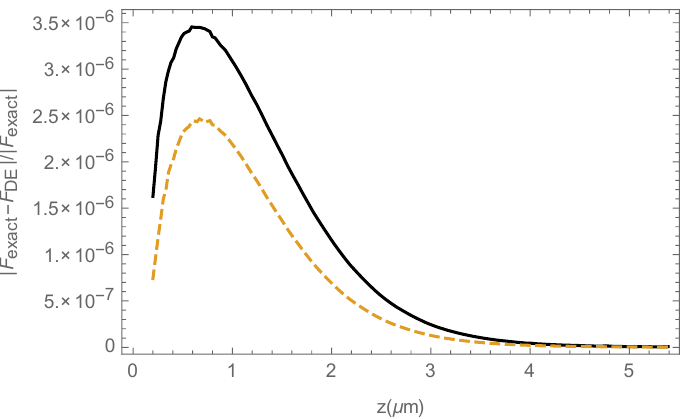
F exact F DE F exact / between the sphere-plate exact Casimir | − | | |